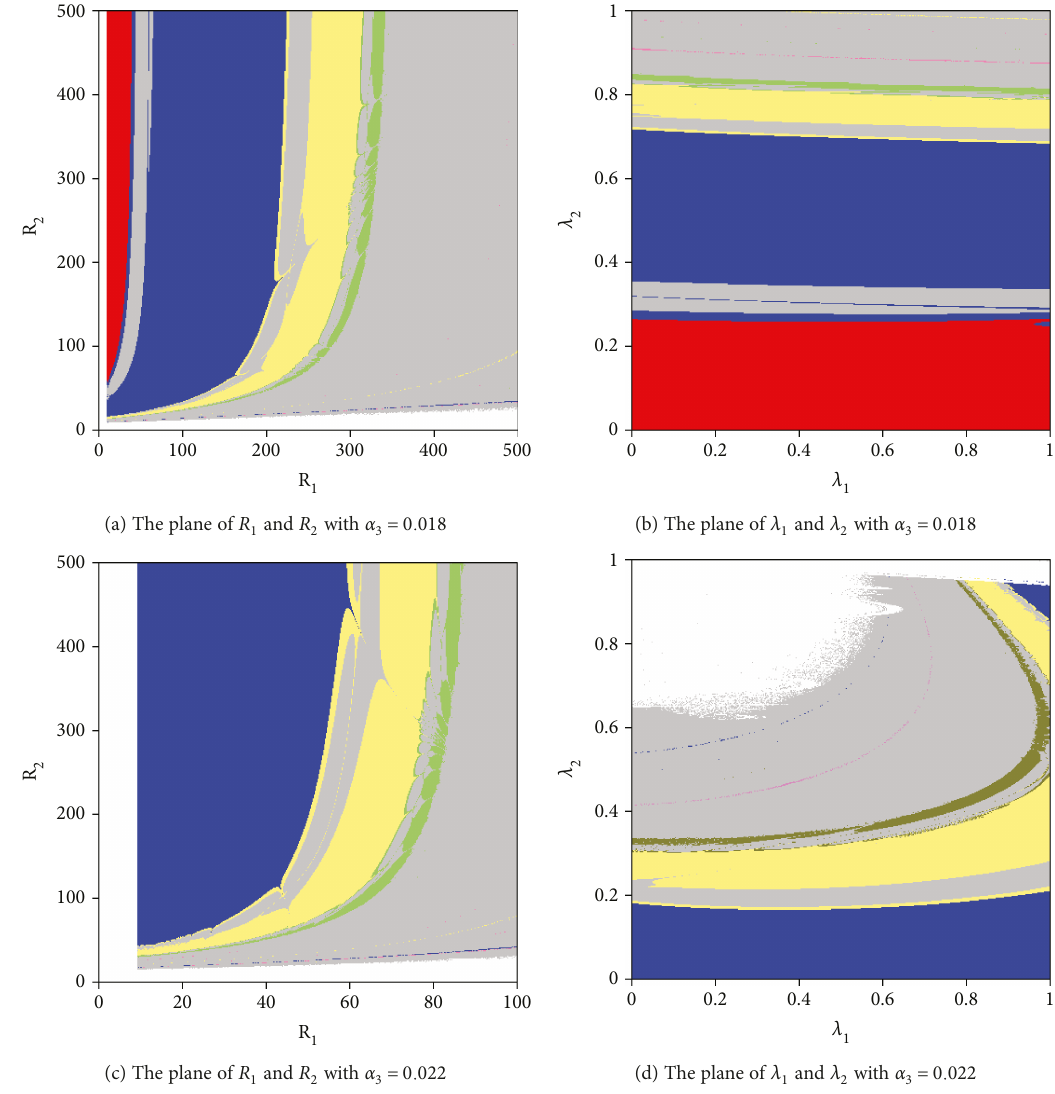
Figure 8: The 2D bifurcation diagram of system